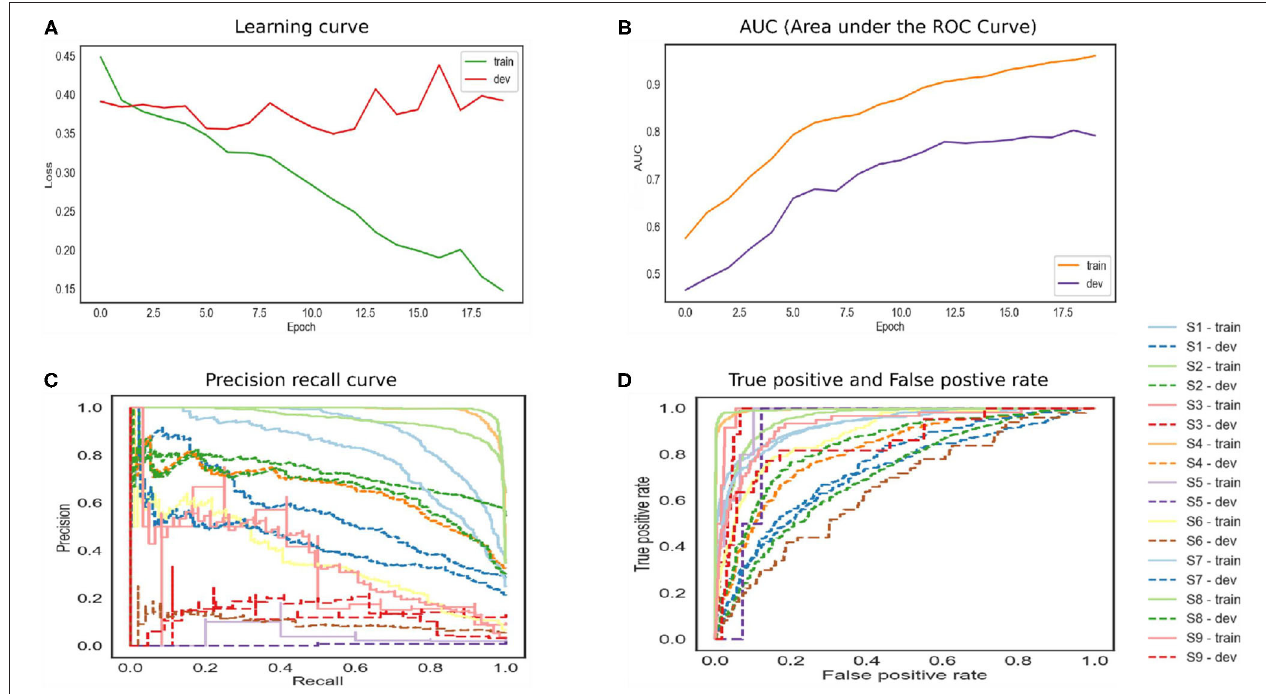
FIGURE 4 | The performance of Long Short-Term Memory (LSTM) model.